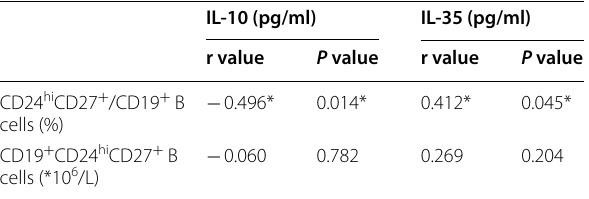
P -value was determined by Spearman’s rank correlation coefficients. * P <